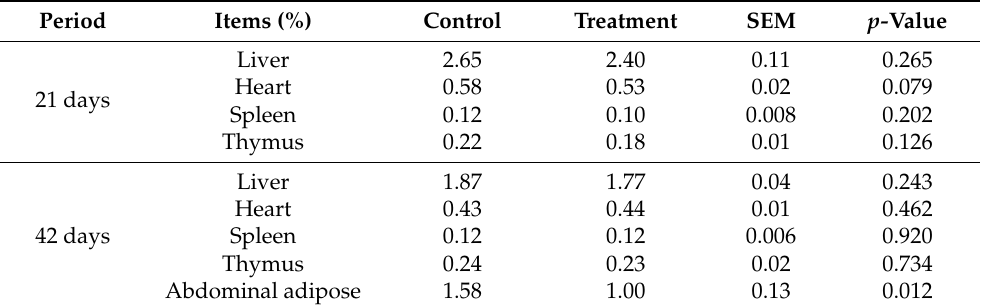
Table 3. Effects of lecithin on the relative organ weight 1 of broilers at 21 and 42 days. Period Items (%) Control